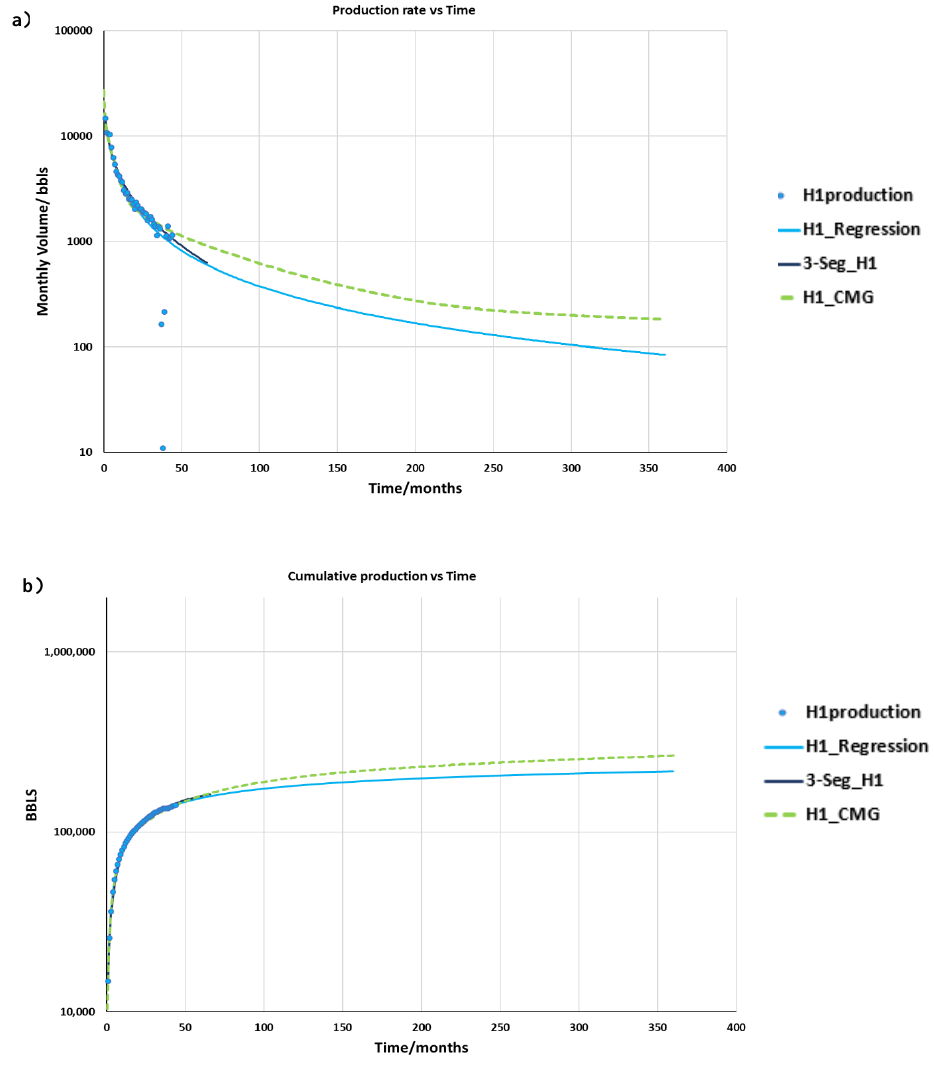
Figure 4. Long-term production forecasts. ( a ) Monthly production rates for H1 well for 44 months data (H1production) with corresponding forecasts from a simple regression (H1_Regression), 3-segment decline curve (3-Seg_H1) and CMG reservoir simulation (H1_CMG). ( b ) Cumulative production for H1 well for 44 months data with corresponding cumulative forecasts from a simple regression, 3-segment decline curve and CMG reservoir simulation (same legends as in (a) ).